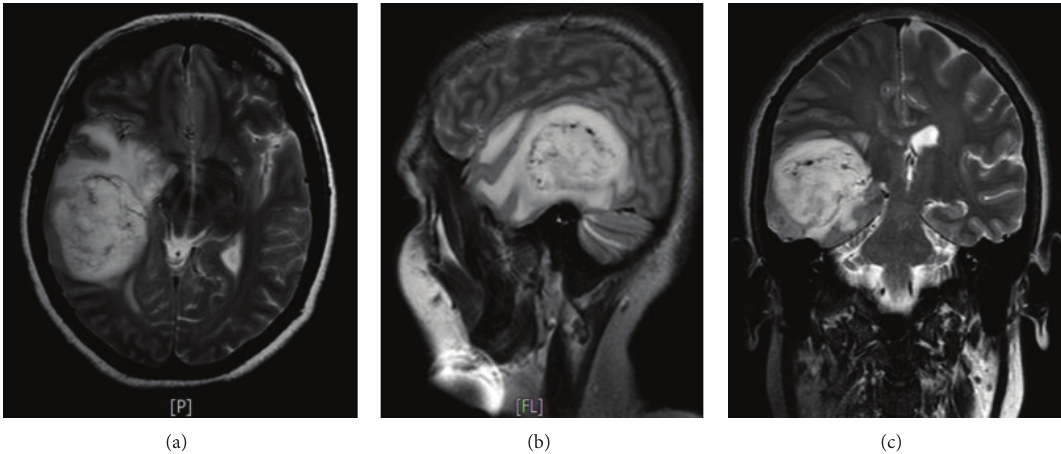
Figure 1: T2 weighted MR images on axial (a), sagittal (b), and coronal planes (c) show heterogenous hyperintense mass lesion on right temporooccipital lobe with prominent peripheral vasogenic edema.